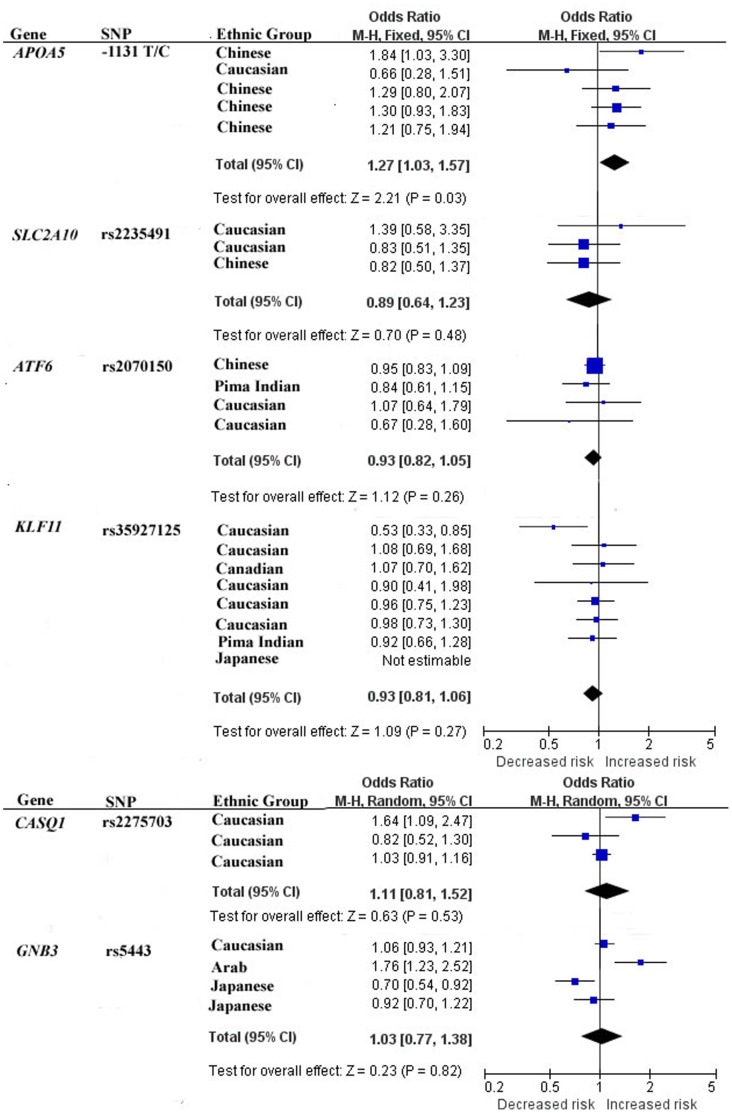
Forest plots of the association studies between six SNPs and T2D.